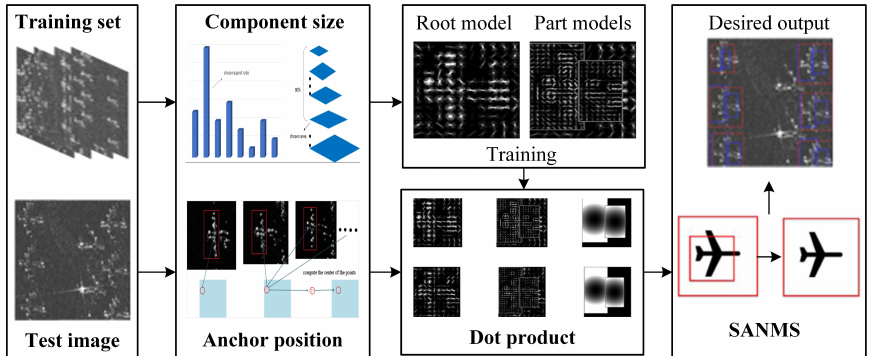
Figure 2. The overall framework of the proposed model. SANMS: Small Area-Based Non-Maximum Suppression